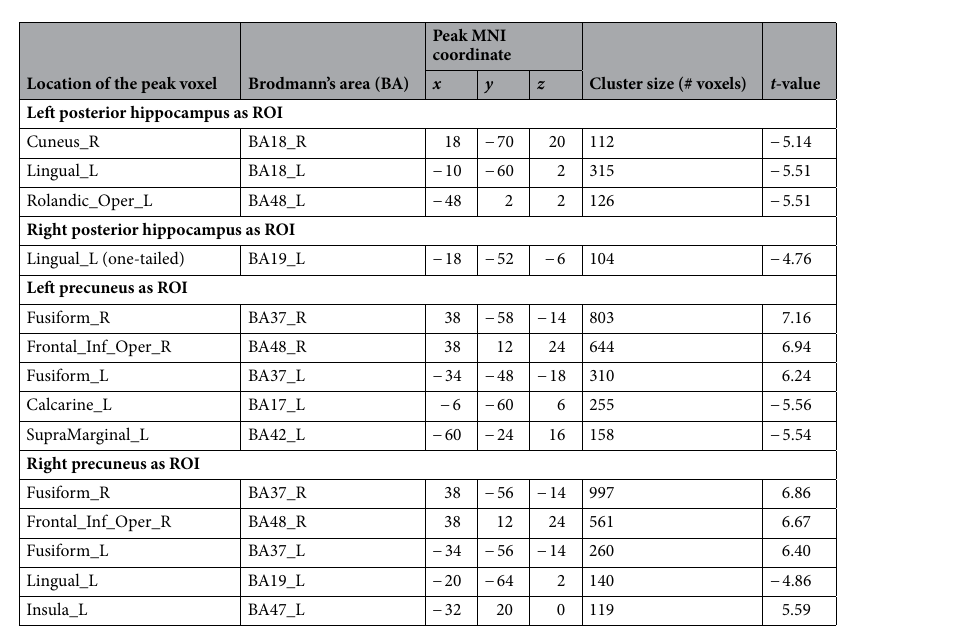
Table 3. Task-dependent functional connectivity obtained from PPI